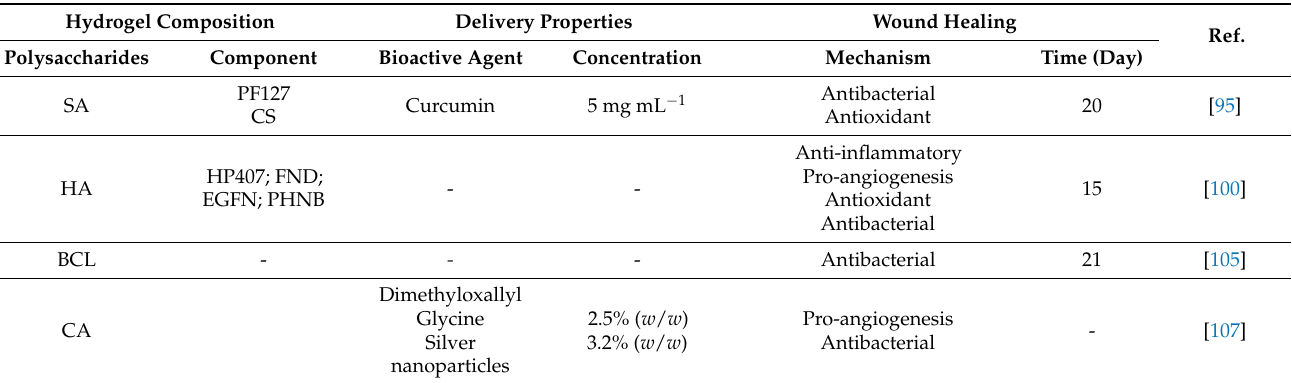
Table 6. Antibacterial polysaccharides-based hydrogels employed in the diabetic wound healing. Hydrogel Composition Delivery